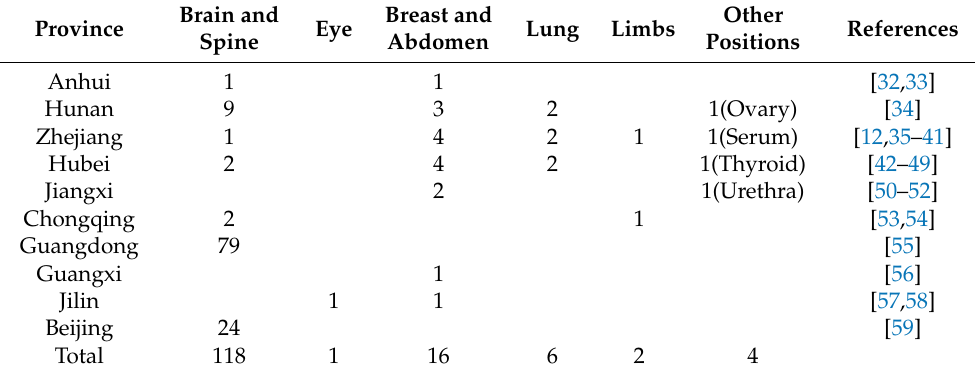
Table 1. Parasitic location of human sparganosis in China